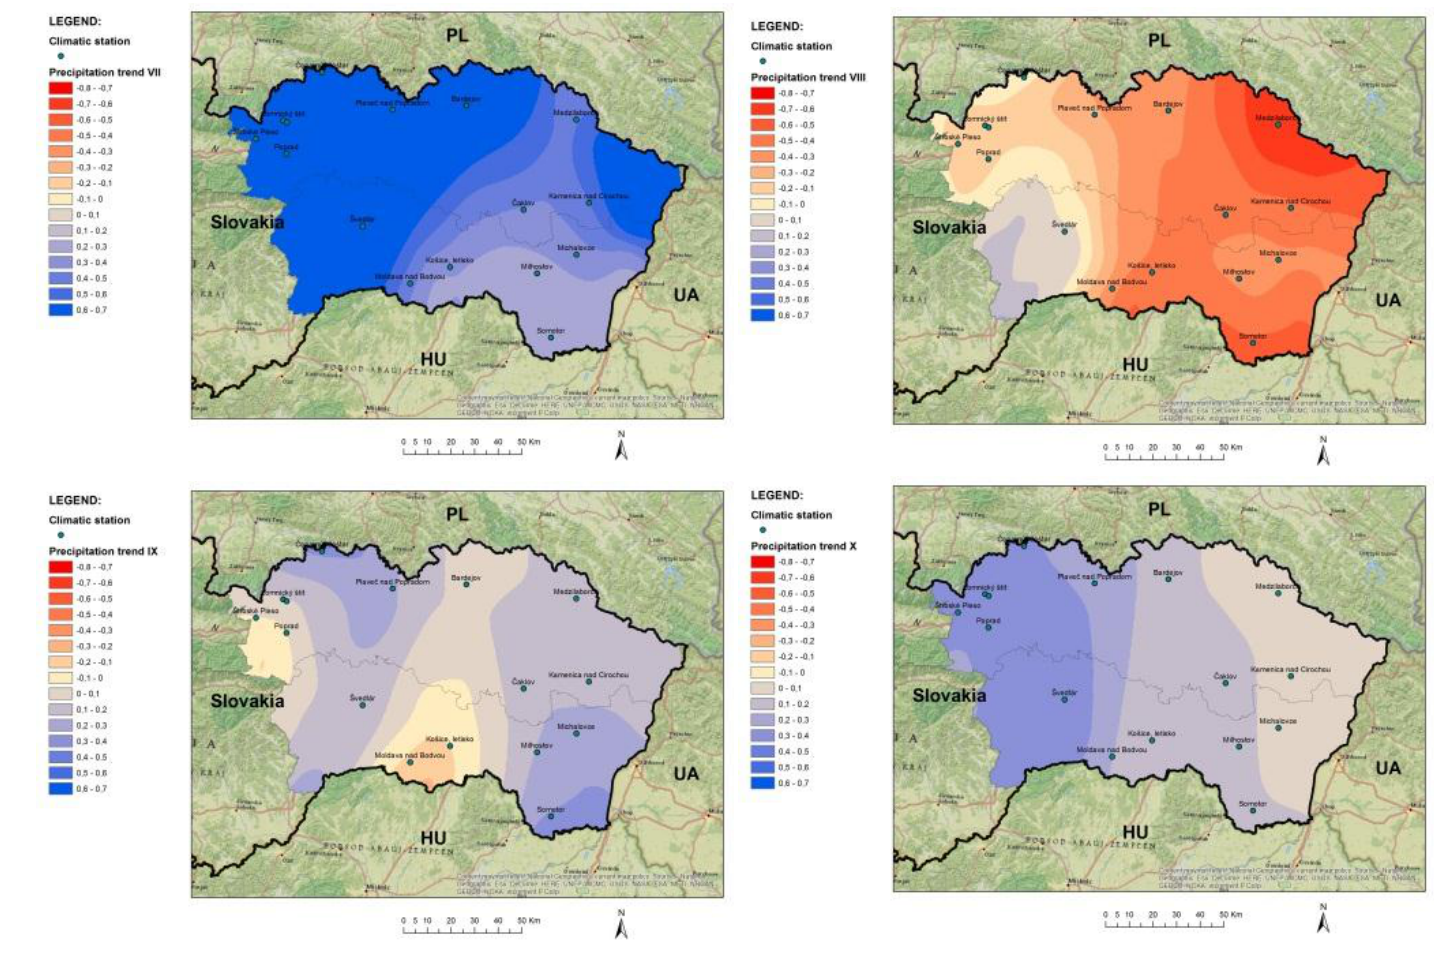
Figure 4. Spatial distribution of precipitation trends.